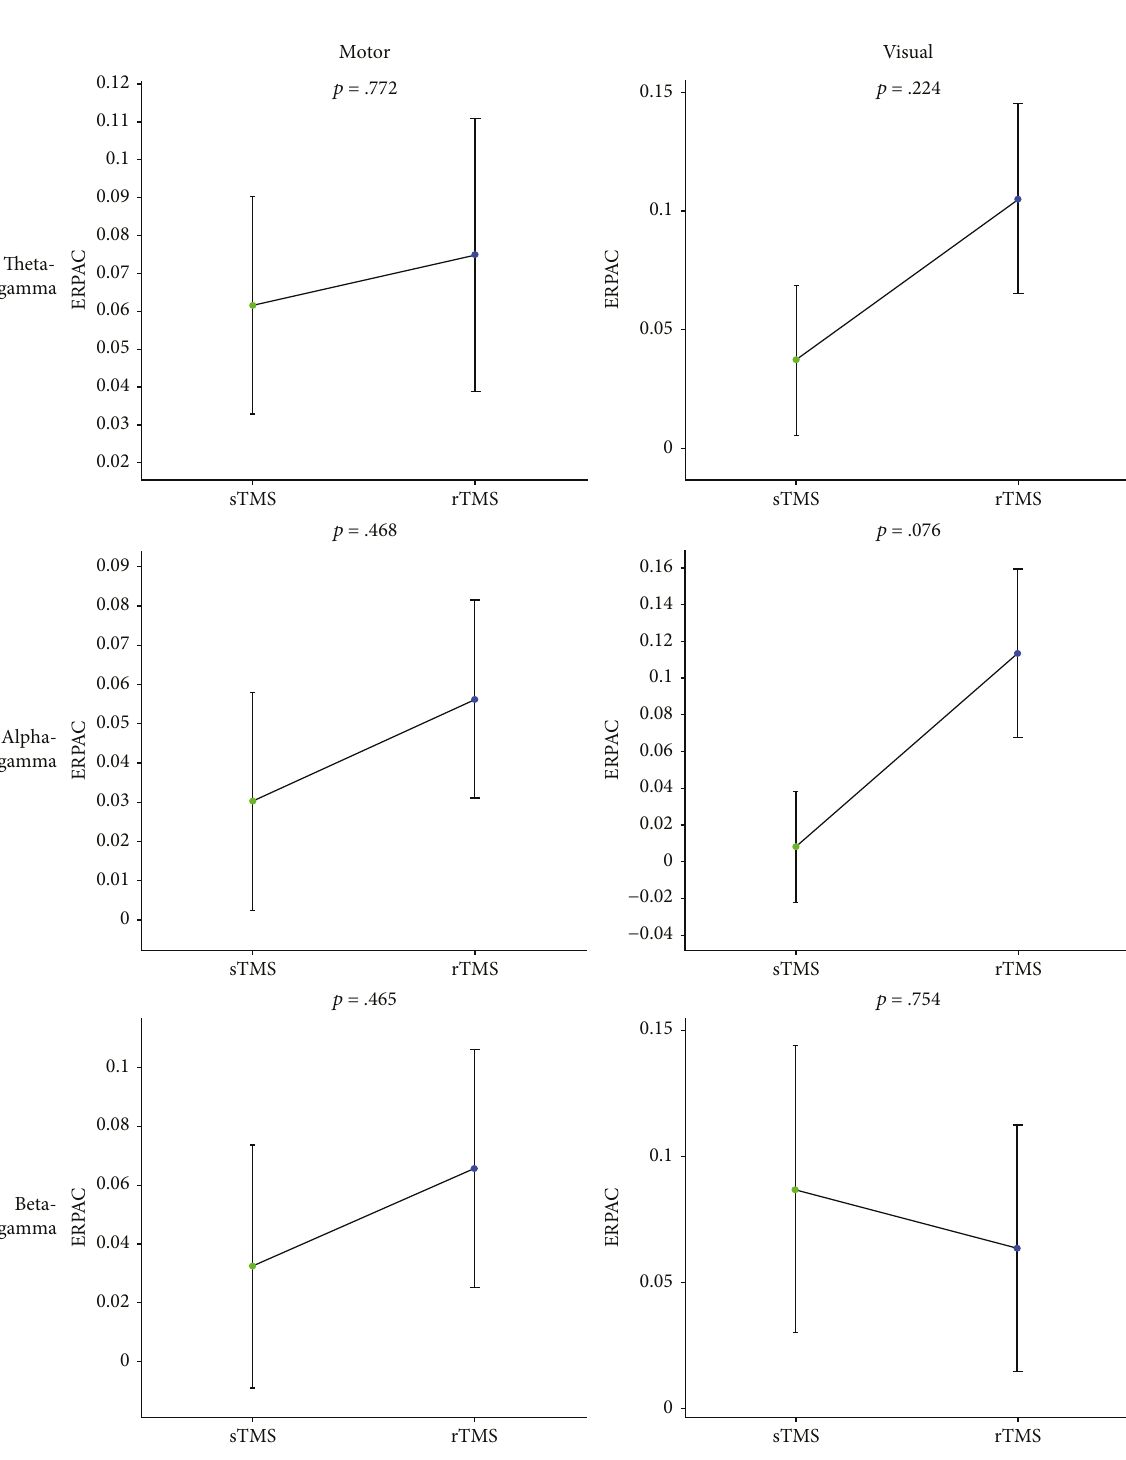
Figure 3: Local comparisons of phase-amplitude coupling between sTMS and rTMS. Plots show the strength of motor-TMS-induced (left column) and visual-TMS-induced (right column) theta-gamma ( fi rst row), alpha-gamma (second row), and beta-gamma (third row) event-related phase-amplitude coupling (ERPAC) during the sTMS pulse in green and the last rTMS pulse in blue, with the rTMS frequency always corresponding to the frequency of the phase series. We extracted TMS e ff ects by averaging ERPAC over electrodes C1 and C3 for motor TMS and electrodes Oz and O2 for visual TMS, subtracting corresponding mean data obtained during sham stimulation, and averaging the resulting values over prede fi ned time windows of interest around the respective pulses and over the sixteen amplitude frequencies. Bars of sTMS and rTMS represent mean values ± 1SEM over the fourteen assessed participants; each displayed p -value is based on a two-tailed paired-sample Student ’ s t -test between the stimulation